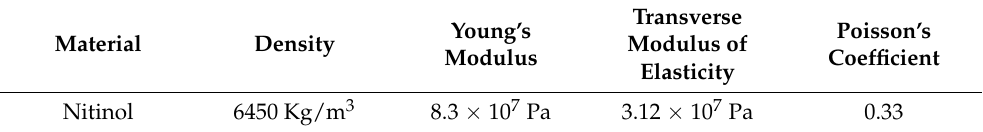
Table 1. Physical properties of Nitinol used in simulations.